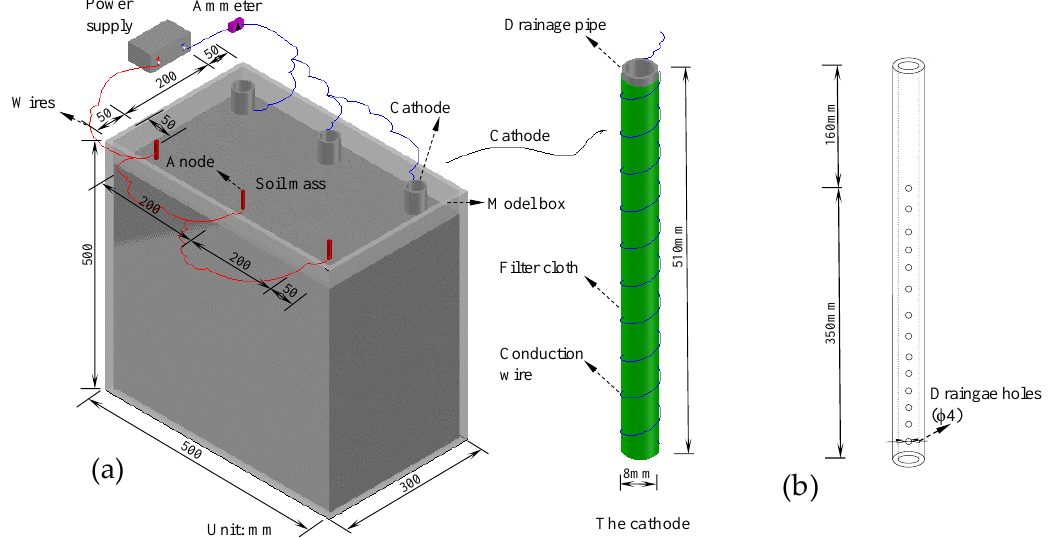
Figure 1. Schematic diagram of the device: ( a ) The model box and cathode; ( b ) The drainage pipe.